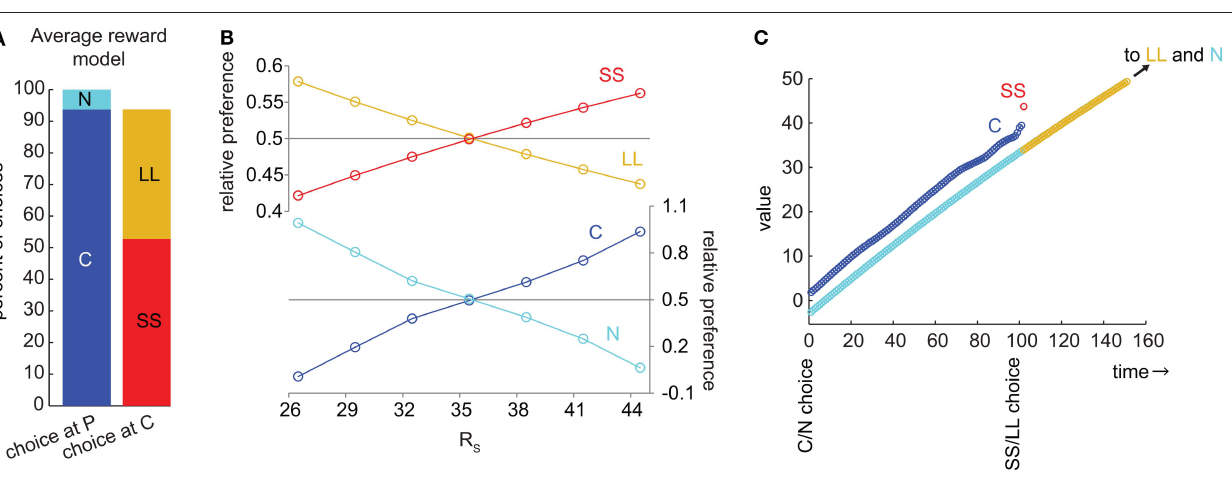
this model would not precommit to avoid an impulsive choice. (C) In the average Figure 3 | The average reward model of hyperbolic discounting cannot reward model, the undiscounted value of C is again between the discounted produce precommitment behavior. (A) At the selected parameters, SS was values of SS and LL. However, the values of C and N never cross, so C is preferred to LL and C was preferred to N. This bar graph represents the same preferred to N whenever SS is preferred to LL. Note that discounting across data as ( B) at R = 44.5. (B) As R increased, the preference for C overtook N S S states in this model is approximately exactly at the same point as the preference for SS overtook LL, meaning that